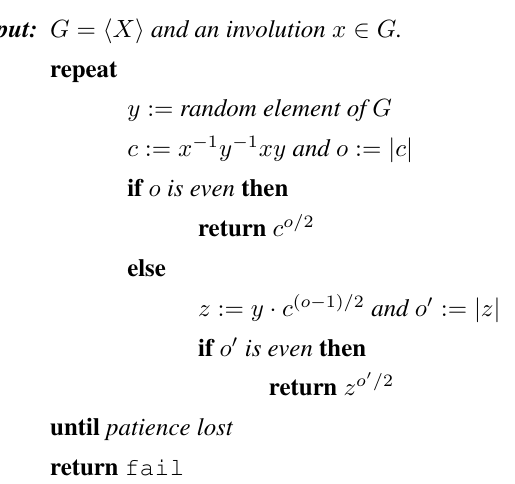
Algorithm 3.3 (I NVOLUTION J UMPER